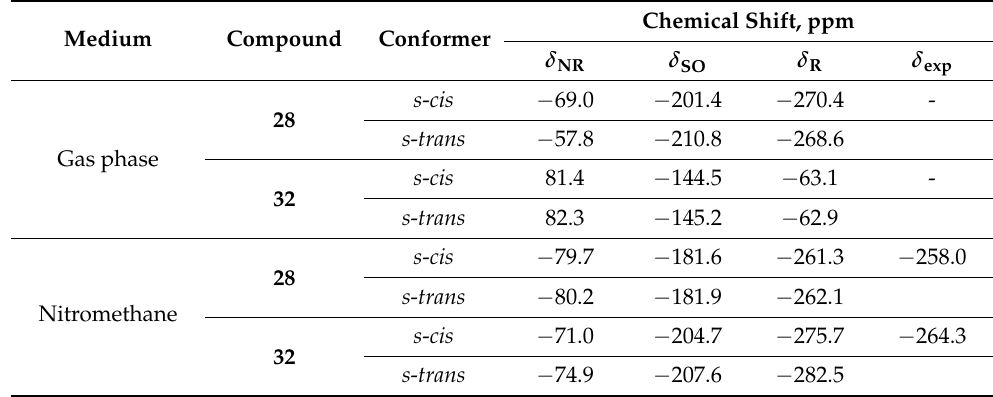
Table 9. The 31 P NMR chemical shifts of complexes 28 and 32 calculated by the GIAO-B3LYP/DZP method, taking into accountspin–orbital interaction in comparison with the experimental data.